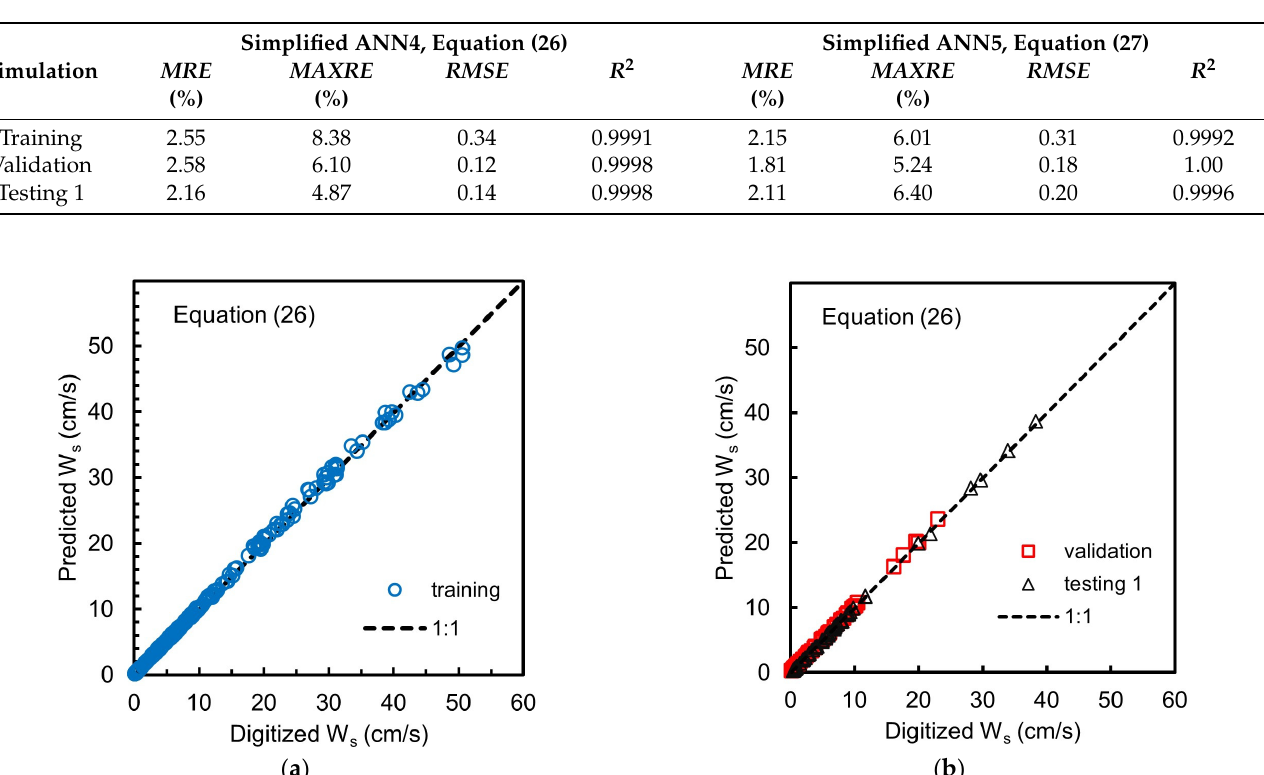
Figure 6. Scattering plot for results of model training ( a ); validation and testing 1 ( b ) for simplified ANN4, Equation (26).